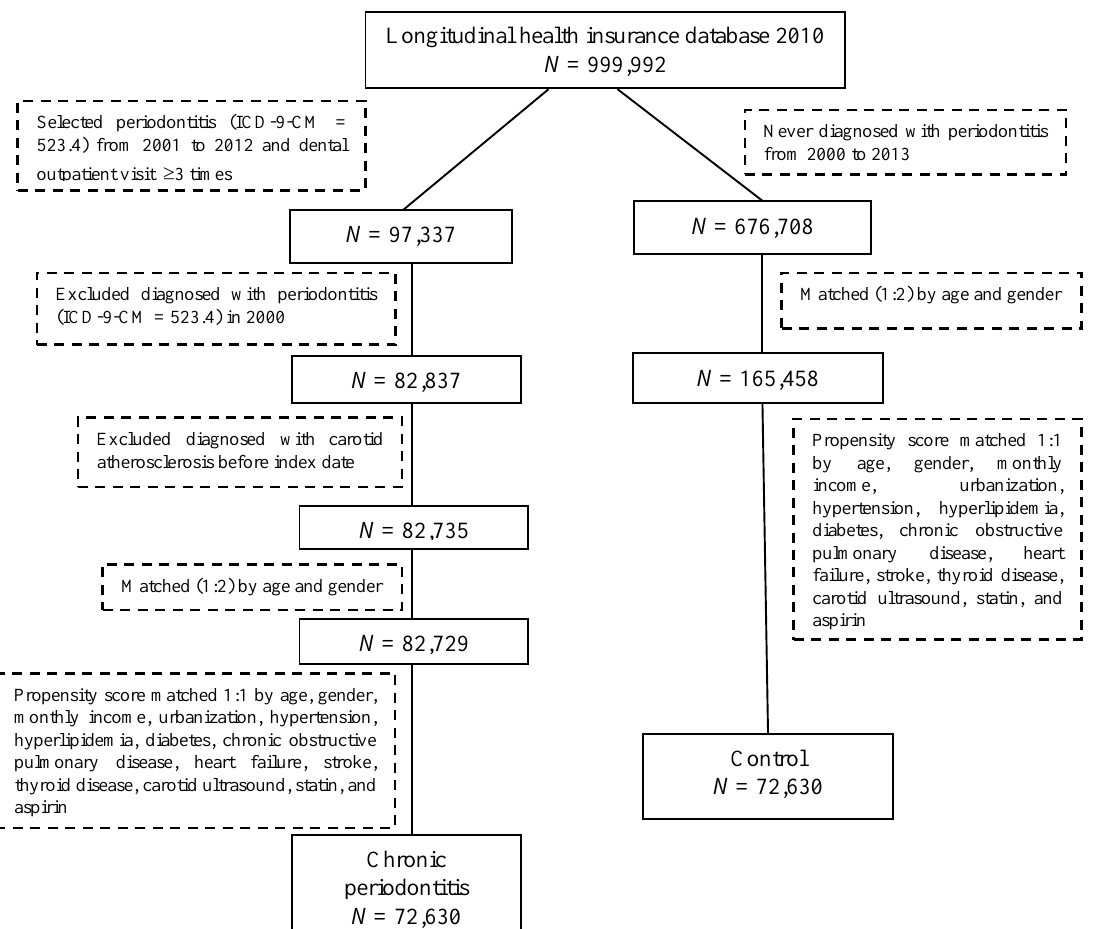
Figure 1. Flow chart of study selection